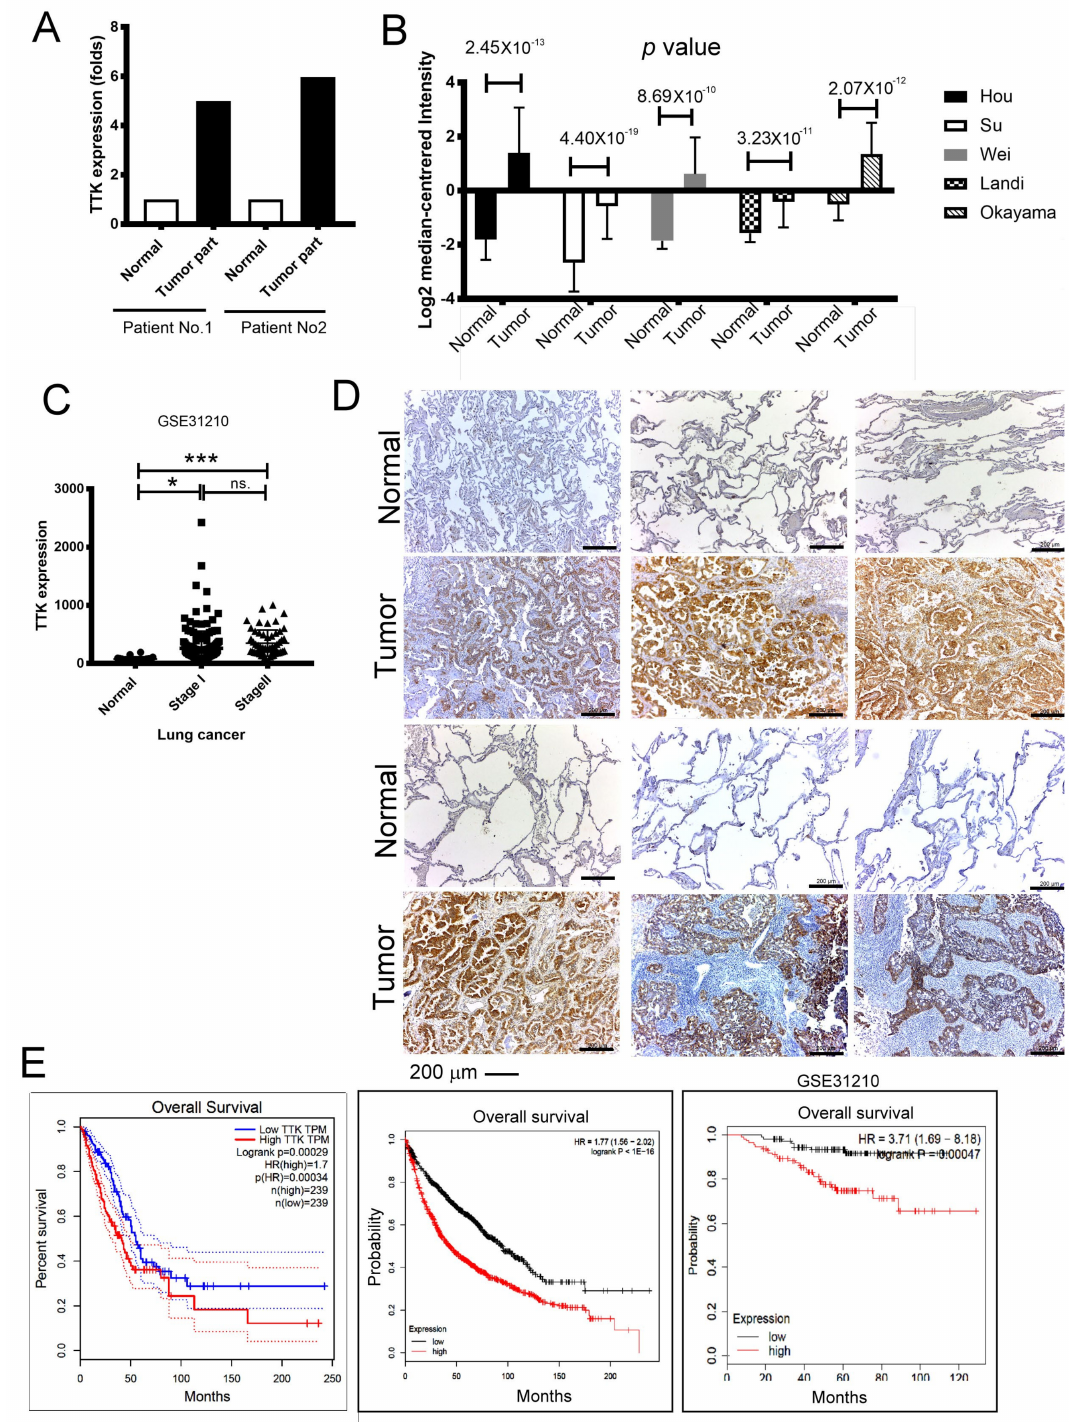
Figure 1. Upregulation of Thr / Tyr kinase (TTK) is correlated with poor prognosis in lung cancer. ( A ) The levels of TTK in 2 lung cancer patients. Increase TTK is found in di ff erent lung cancer patient database obtained from Oncomine ® ( B ) and GEO (GSE31210) ( C ). ( D ) The immunohistochemical (IHC) staining of TTK of the specimens of 6 out of 9 patients lung cancer patients, the higher intensity of TTK staining in the tumor parts when comparing with normal lung parts. ( E ) The relation of TTK expression with clinical outcome in lung cancer patients. The group was divided according to GEPIA, the KM plotter website and GSE31210 dataset. * Significant di ff erence between the two test groups (* p < 0.05, *** p <